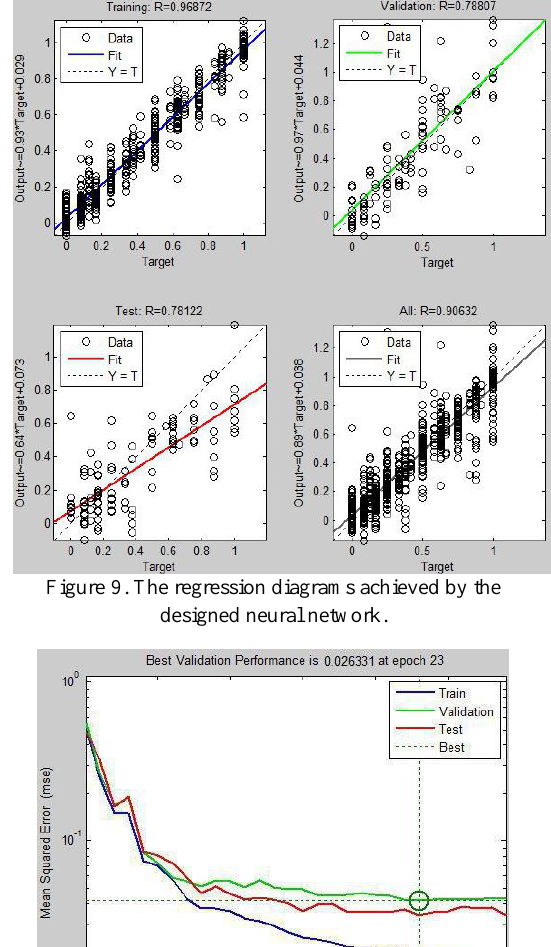
Figure 10. The performance (MSE) of the proposed neural